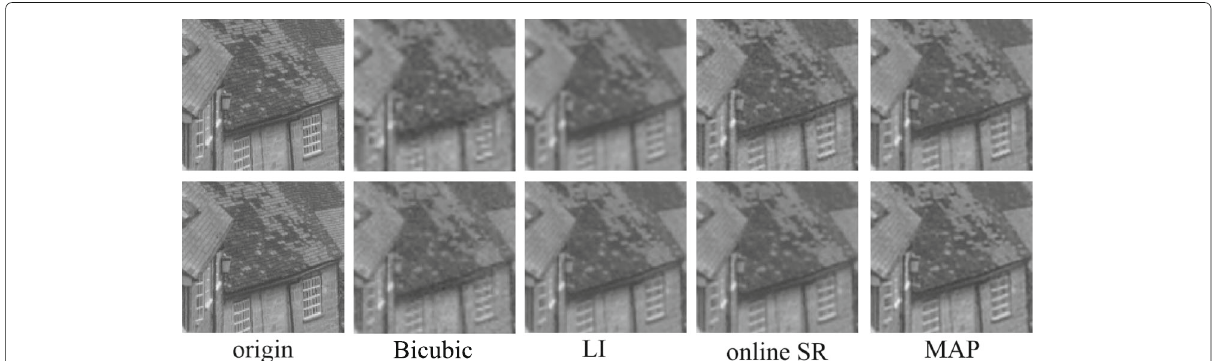
Fig. 4 Comparison of results of different reconstruction methods. From left to right: origin original HR image, reconstructed HR image using bicubic interpolation, LI, OSR, and MAP. Top row: images reconstructed with a up-sampling factor of 3 (except for the origin original image). Bottom row: images reconstructed with a up-sampling factor of 2 (except for the origin original image)